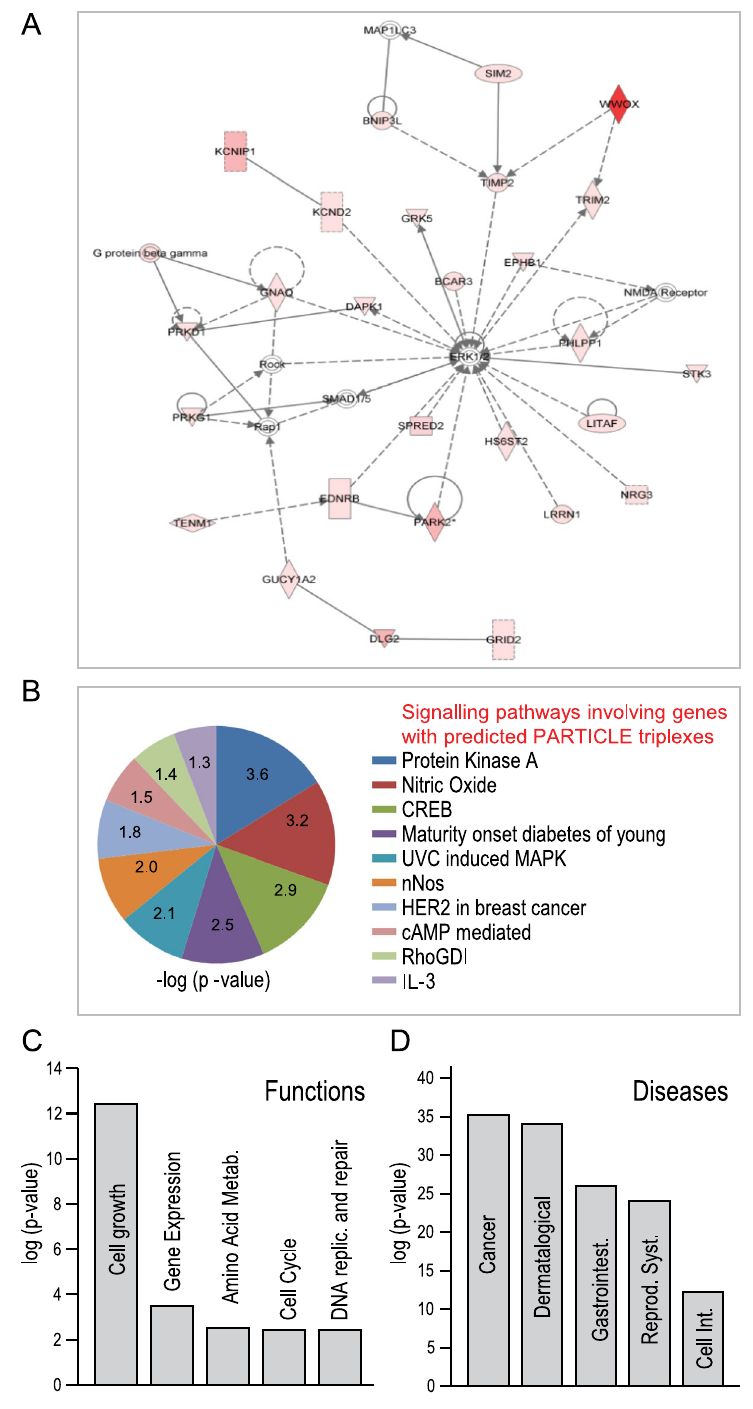
Figure 5. Ingenuity ® Analysis ™ software (www.ingenuity.com) used in the analysis of genes with predicted PARTICLE triplex binding sites (Fig. S1 Triplex Domain Finder) associated with signaling pathways, molecular functions and diseases. ( A ) Graphical representation of genes with predicted PARTICLE triplex binding sites (pink) associated with the ERK 1/2 regulatory network. The predominance of triplexes within WWOX is shown in red. ( B – D ) Significantly associated signaling pathways ( B ), molecular functions ( C ) and diseases ( D ) involving genes with predicted PARTICLE triplexes. Pie chart ( B ) or histograms ( C , D ) of associated –log of the calculated p-value whereby a significant p value of p < 0.05 is equivalent to − log =